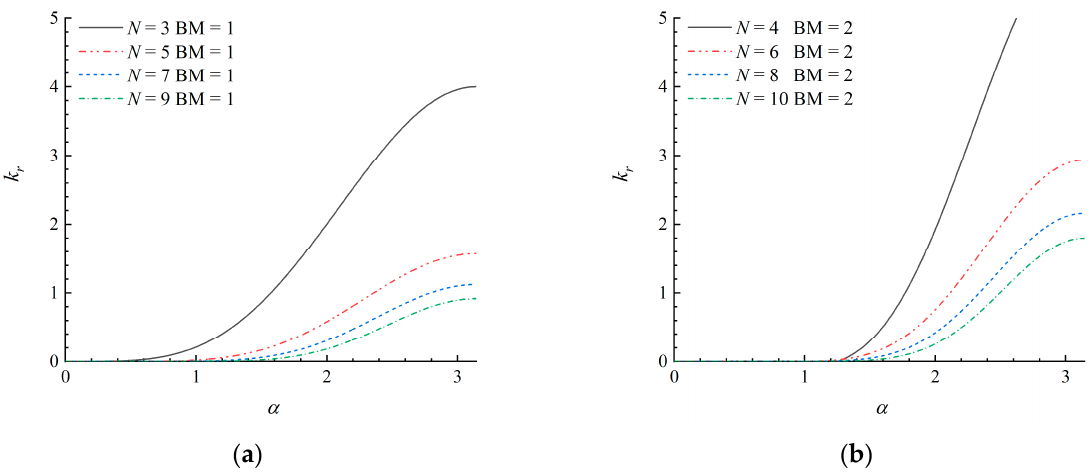
Figure 5. Dissipation analysis of the different wavelet schemes: ( a ) N ∈ odd; ( b ) N ∈ even.